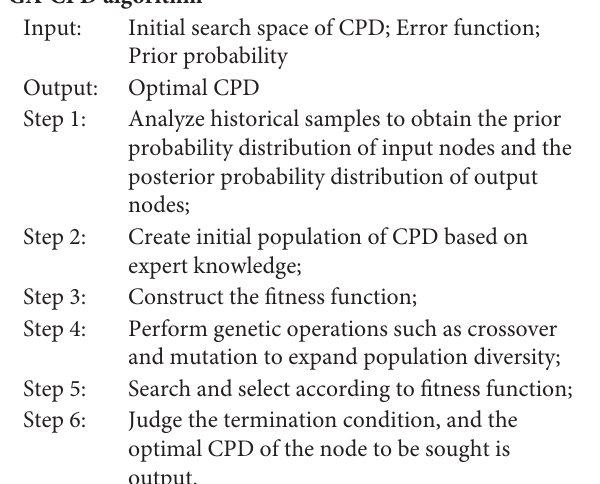
support of large-scale data sets. The learning efficiency is less affected by the degree of data missing and the complexity of network, and the convergence speed is faster. The algorithm flow is elaborated as follows.